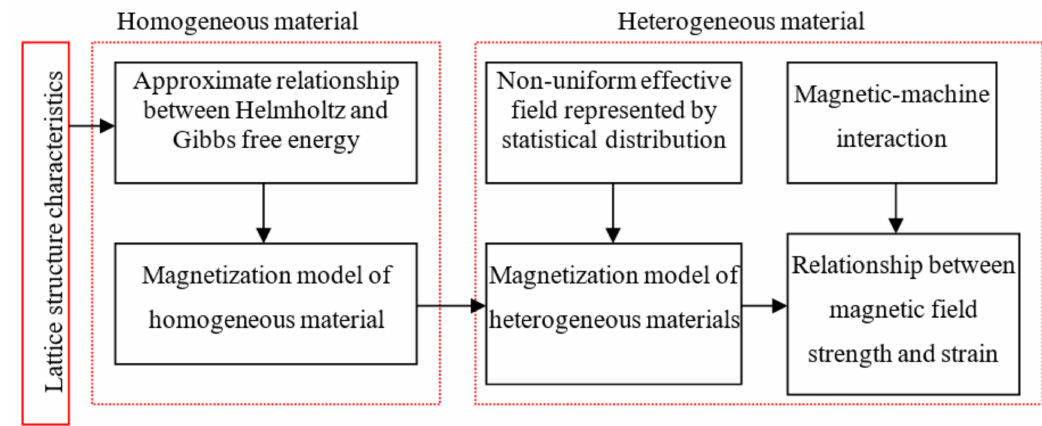
Figure 2. Free energy hysteresis model construction process.